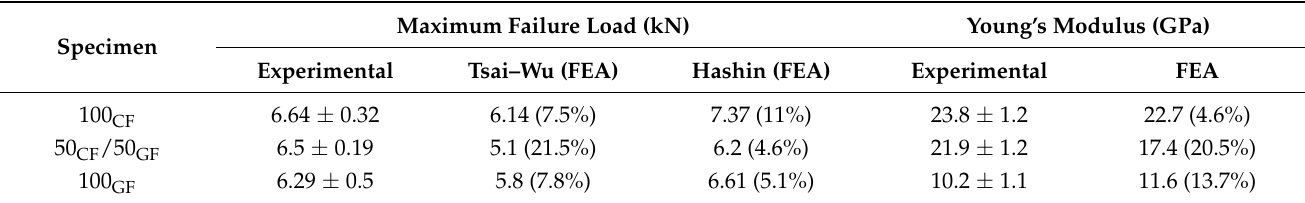
Table 7. Comparison between the experimental and the tensile test results predicted by Tsai–Wu and Hashin failure criterion with the relative errors.